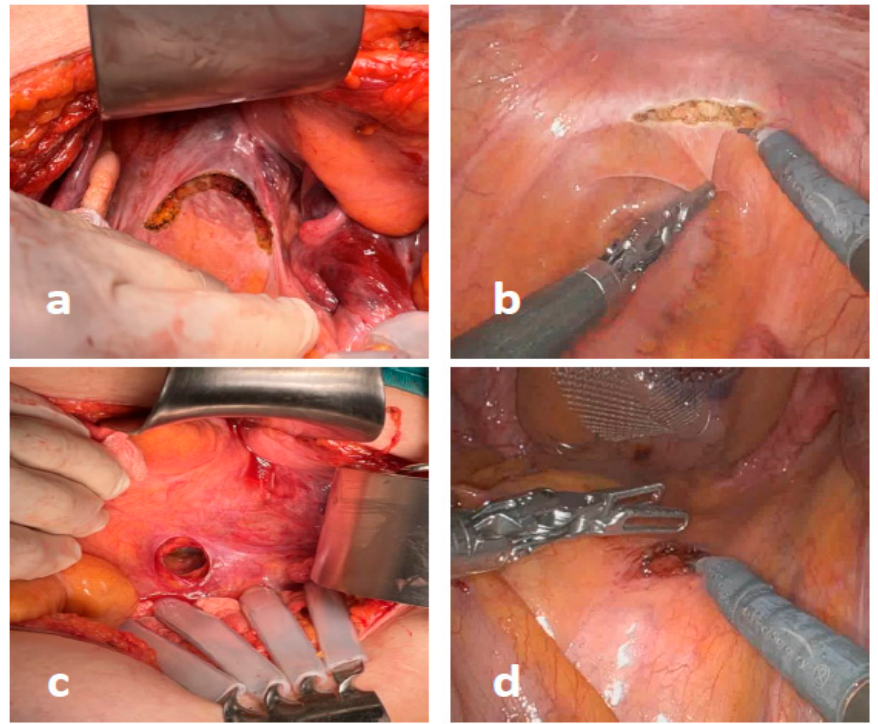
Figure 1. Peritoneal incisions were performed at the pouch of Douglas ( a , b ) and sacral promontory ( c , d ) in open and robotic surgery.